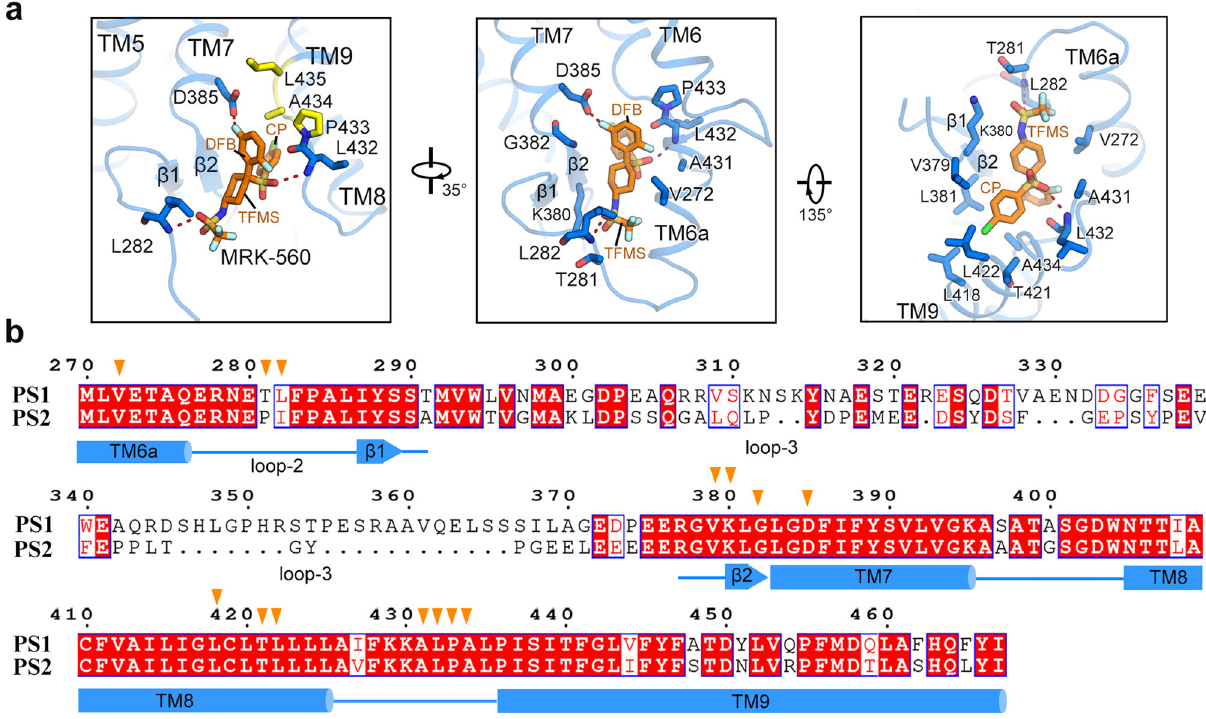
Fig. 3 | Speci fi c recognition of MRK-560 by PS1. a Coordination of MRK-560 by PS1. MRK-560 forms three H-bonds with Leu432, Leu282 and Asp385 of PS1 in addition to extensive van der Waals contacts with surrounding residues. H-bonds are shown as red, dashed lines (left panel). b Identi fi cation of the determinant for